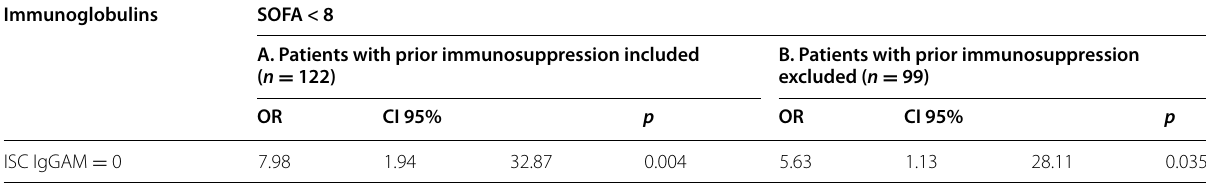
Adjusting variables for A. were (age) (presence of prior immunosuppression) (APACHE‑II score) (microbiologically confirmed infection). Adjusting variables for B were (APACHE‑II score) (respiratory infection) (microbiologically confirmed